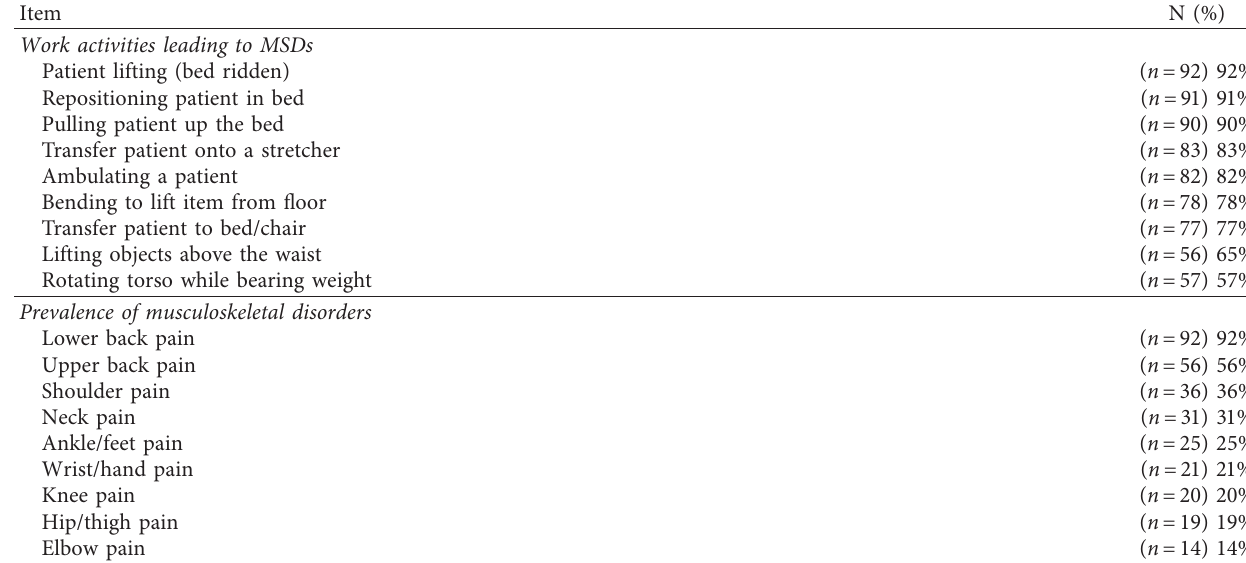
Table 2: Work activities leading to MSDs and prevalence of musculoskeletal disorders.